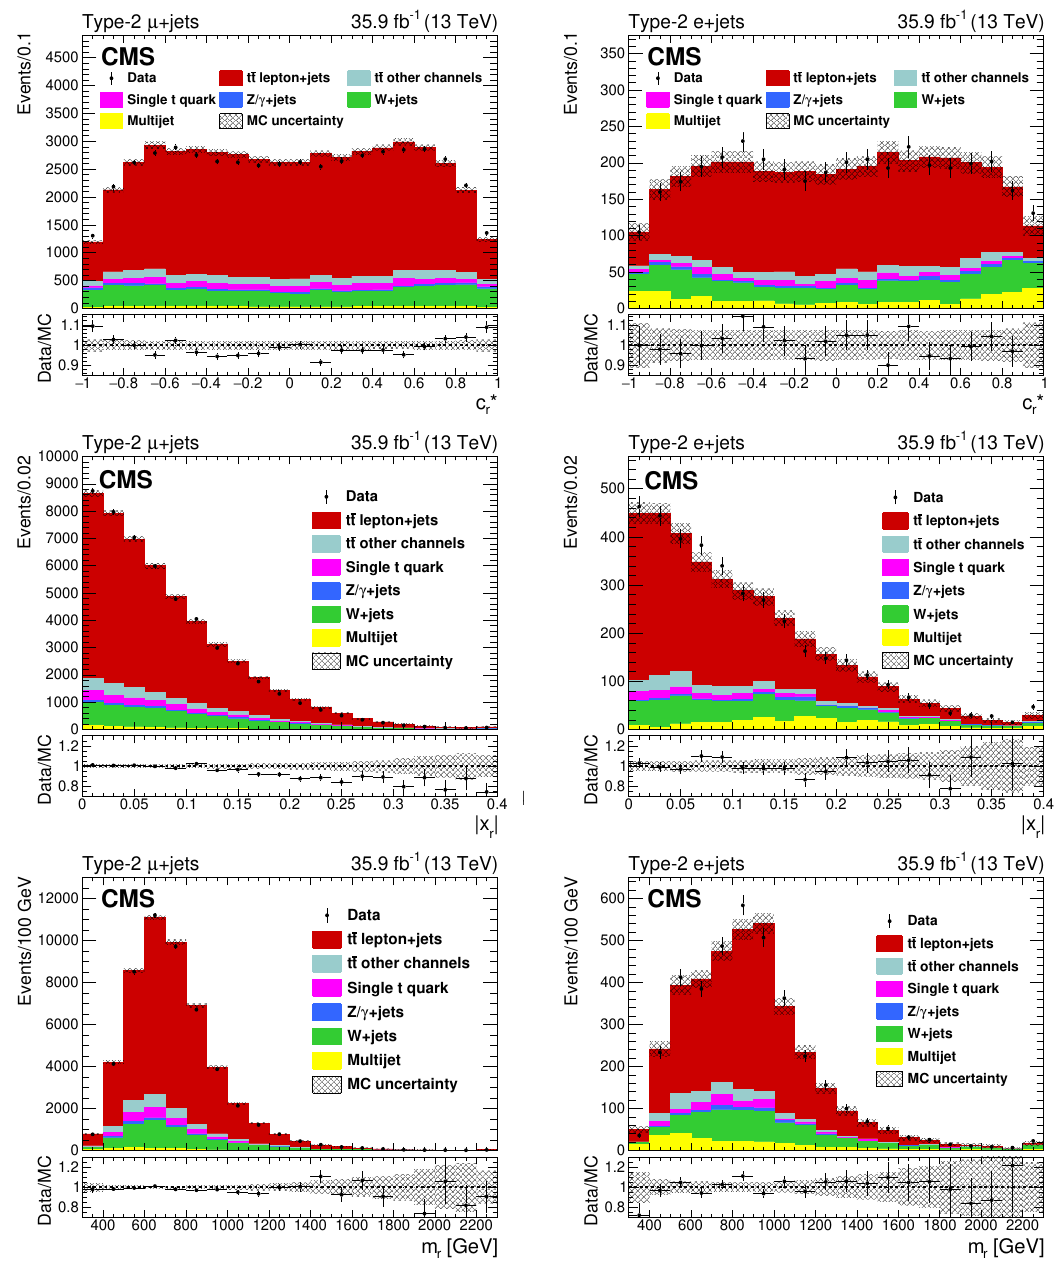
Figure 5 . Data/MC comparison of reconstructed c (cid:3) events passing type-2 m +jets (left column) and e+jets (right column) selection criteria. The MC signal and background show their nominal predictions, with the MC uncertainty pictured in the hatched bands representing statistical uncertainties. The contribution from multijet background is estimated from data, as discussed in section 6. The lower panels of each (cid:12)gure show the ratio of the observed data to MC expectation in each bin, and the last bins of the j x